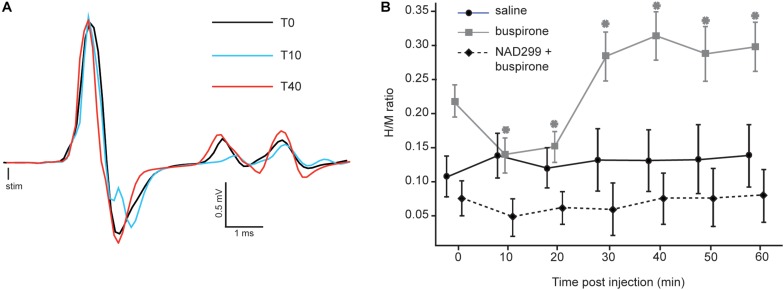
Effect of buspirone on the H-reflex. (A) Averaged EMG traces obtained at three critical time points after buspirone administration. The H-reflex amplitude shows an initial decrease 10 min after buspirone administration (blue trace) and an increase 40 min after buspirone (red trace). (B) Mean H/M ratios for mice from the three groups. For the buspirone group (gray line), the mean H-reflex is significantly lower than baseline at 10 and 20 min after buspirone whereas it is significantly higher than baseline at 30–40–50 and 60 min (∗p < 0.01). The amplitude of the mean H-reflex over time is no different than baseline in the saline group (black line) or the NAD-299 + buspirone group (dotted line).